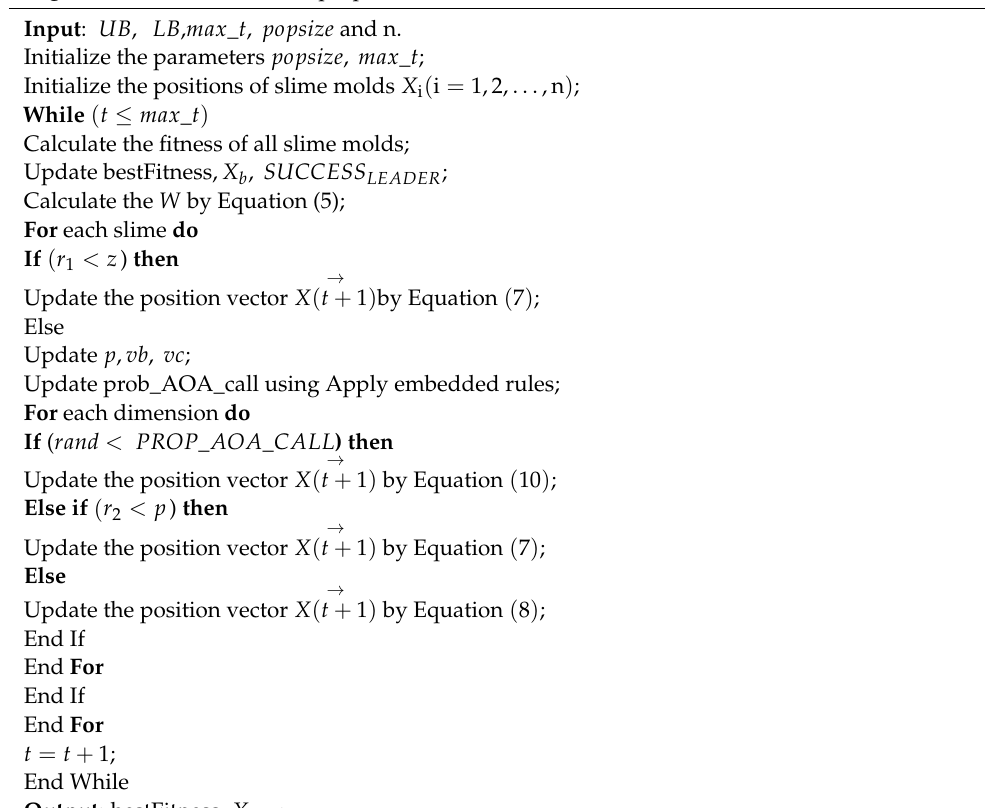
Algorithm 1: Pseudo-code of proposed